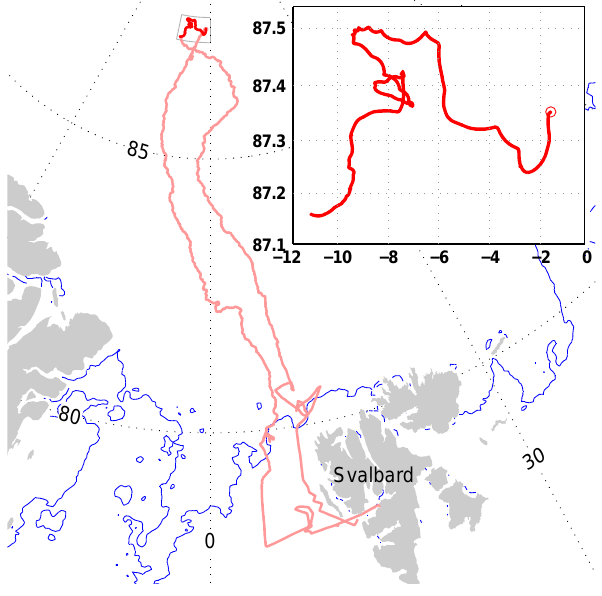
Fig. 1. Cruise track of ASCOS shown in red with the ice-drift in the insert. Thin blue line is the observed ice edge on 12 August, 2008.